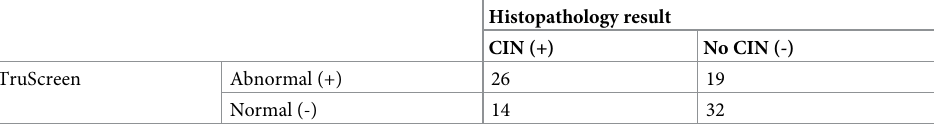
Table 1. Cross table for calculations of sensitivity and specifity of TruScreen for abnormal cervical biopsy